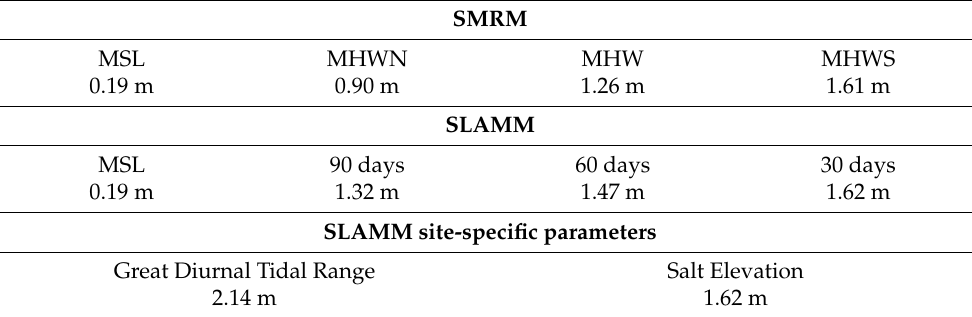
Table 2. Tidal levels for SMRM and SLAMM in